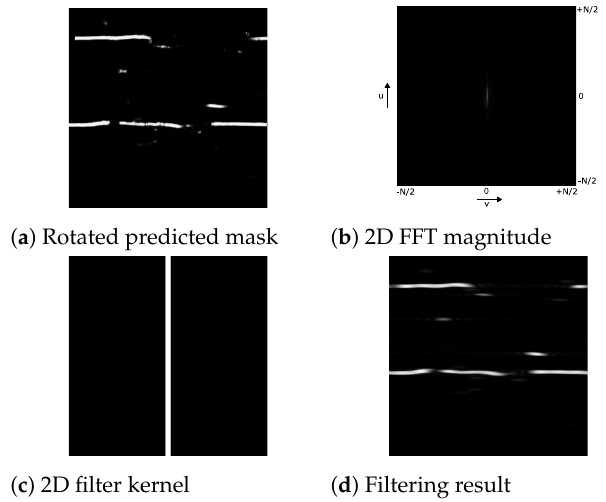
Figure 4. Two-dimensional filtering in Fourier domain to reduce nonhorizontal lines. In ( a ), the horizontally aligned predicted segmentation mask, in ( b ), its 2D FFT magnitude, in ( c ), the 2D filter kernel, and in ( d ), the filtering result of the rotated predicted segmentation mask is shown.